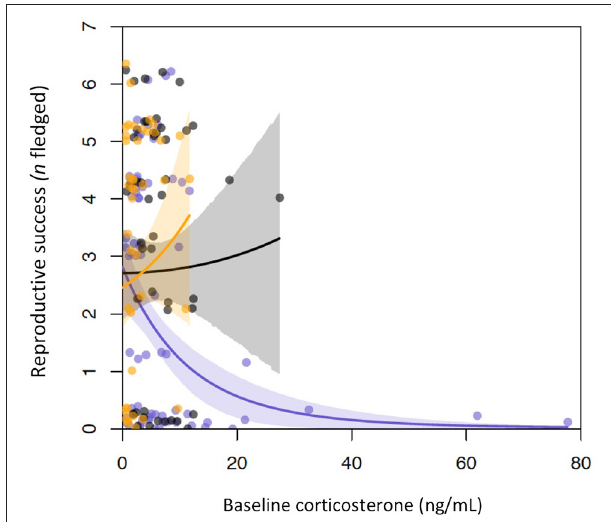
FIGURE 1 | Baseline glucocorticoids and reproductive success by year in incubating female tree swallows. Baseline levels were negatively associated with reproductive success in 2013 (purple points and line), but not in 2014 (gray), or 2015 (orange). Lines show the relationships between baseline corticosterone and reproductive success during each year, as predicted by generalized linear mixed